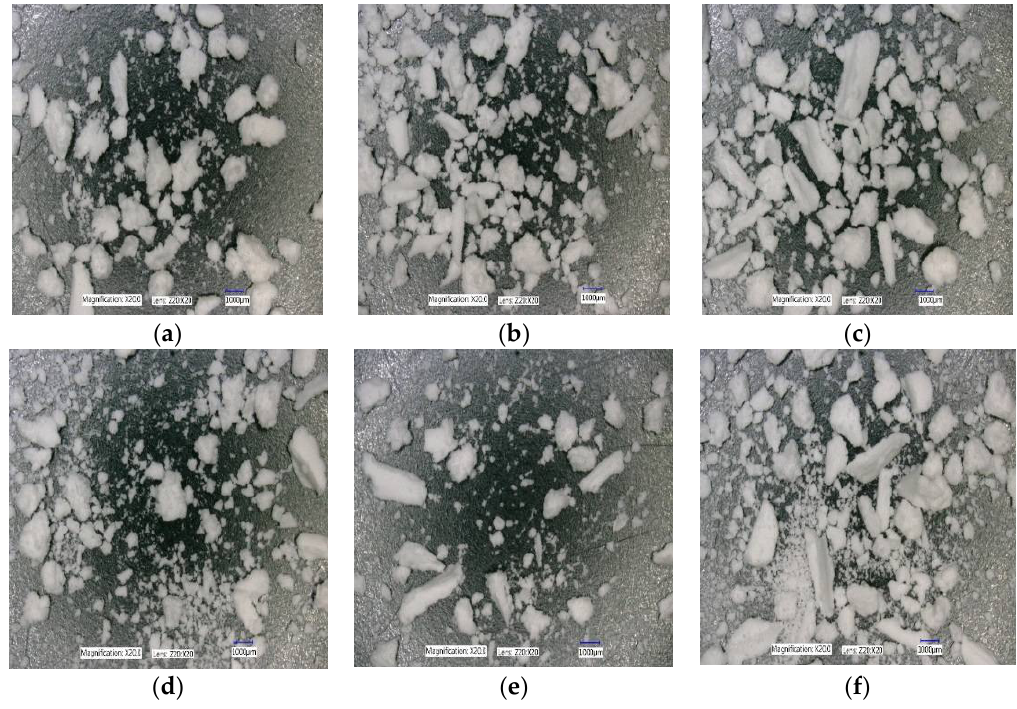
Figure 19. Microscopic images of MCC granules produced at varying screw speed at SFL—0.083 and